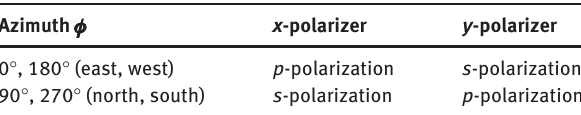
Table 1: Dependence of polarization of incident light on azimuthal angle and orientation of linear